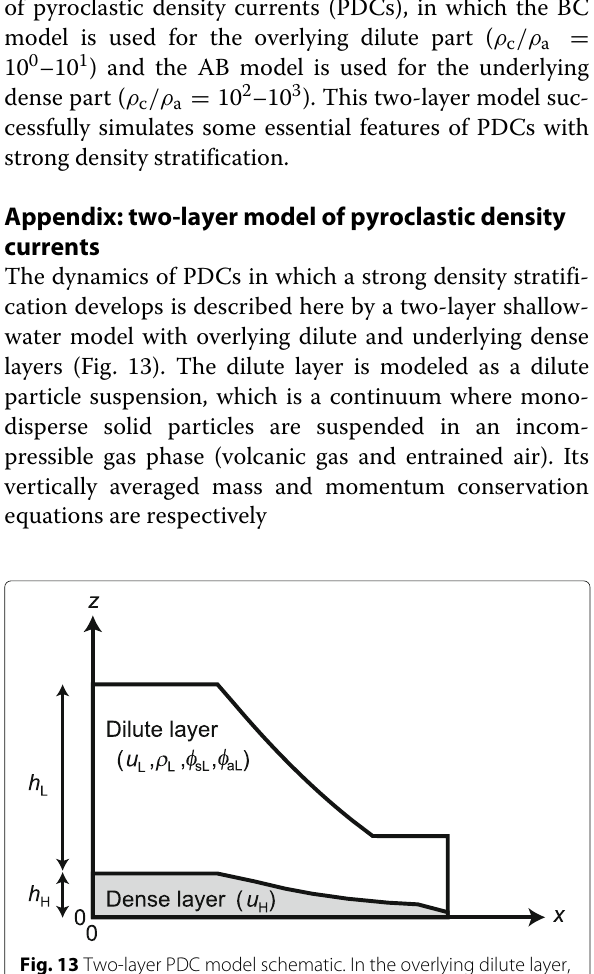
Fig. 12 Numerical results of a two-layer PDC model for the dam-break problem. The dense current height ( h H ) and dilute current height ( h L + h H ) at a t = 1 and b t = 10 are shown. A PDC is generated by the instantaneous release of an initially homogeneous dilute layer. The overlying dilute layer /ρ = 8.495) is calculated using the BC model, and the underlying dense layer ( ρ (initially ρ ∗ a L ε = 10 − 10 . Shear drag is applied for the basal resistance of the dense layer. The variables are non-dimensionalized using the initial values of the dilute layer (e.g., Eqs. (4) and (5)). Given parameters: aspect ratio (initial height/initial length) = 1; initial particle concentration of the dilute layer = 0.005; density ratio (particles/air) = 1500; density ratio (volcanic gas/air) = 1; and the non-dimensional particle settling speed = 0.05